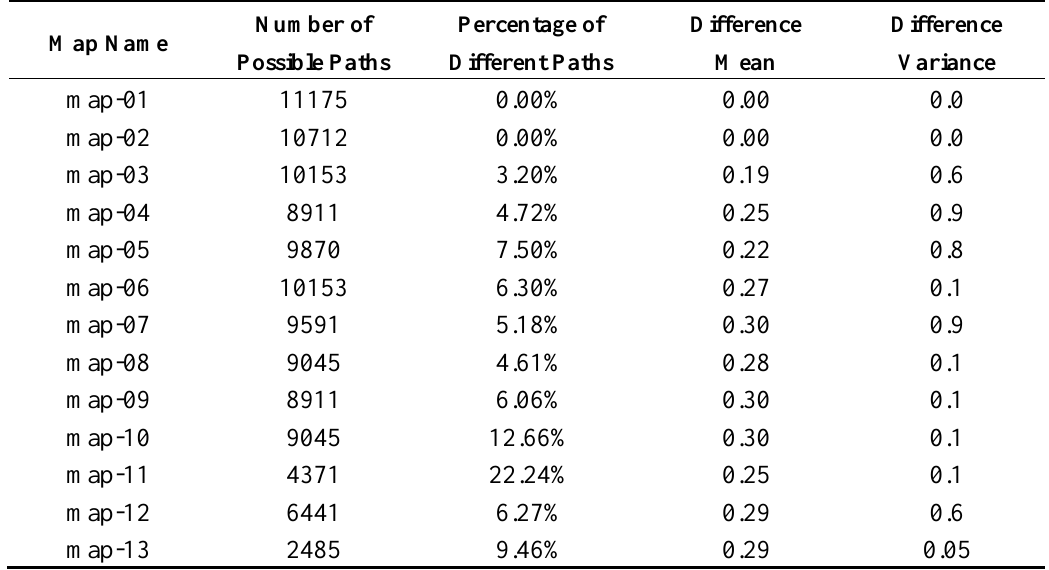
Table 2. Path-length comparison results (mean and variance). The cell‟s width is unitary (